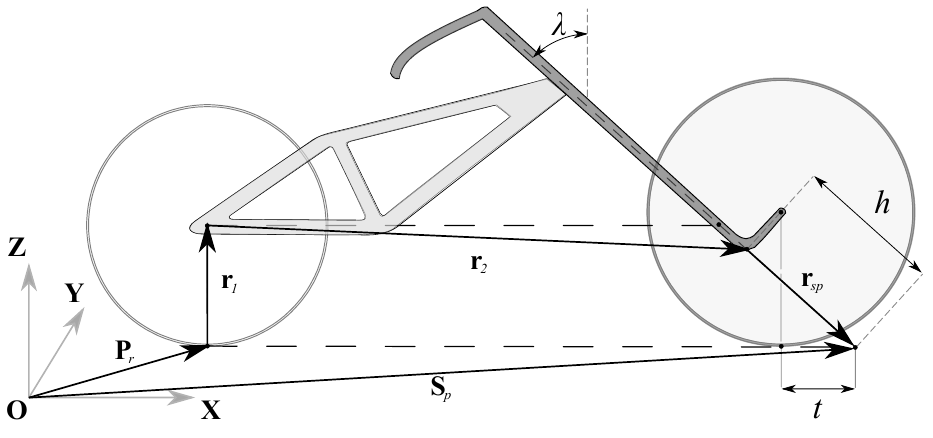
Figure 7. Position vector of the steering